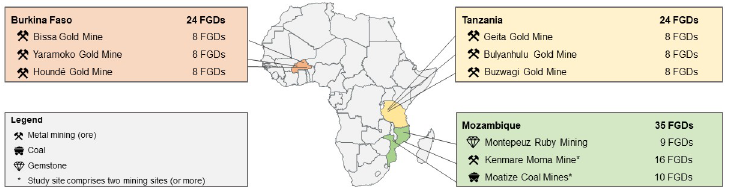
Fig 1. Overview of countries and study sites. Map indicating study countries, study sites and number of focus group discussions (FGDs) conducted (between March 2019 and January 2020).